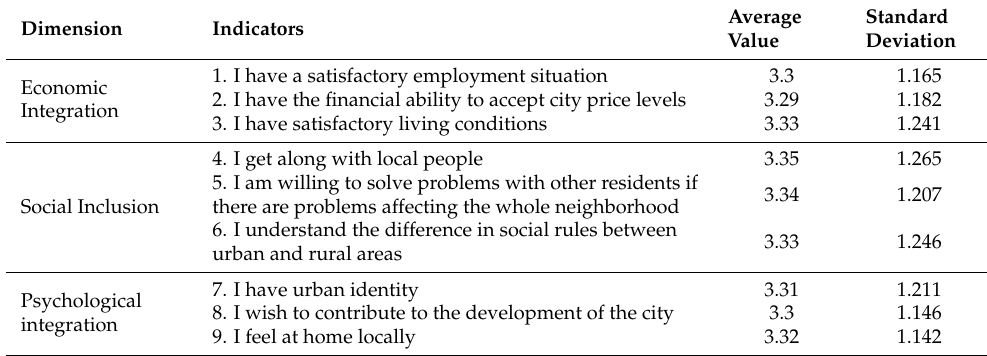
Table 3. Urban integration evaluation index.